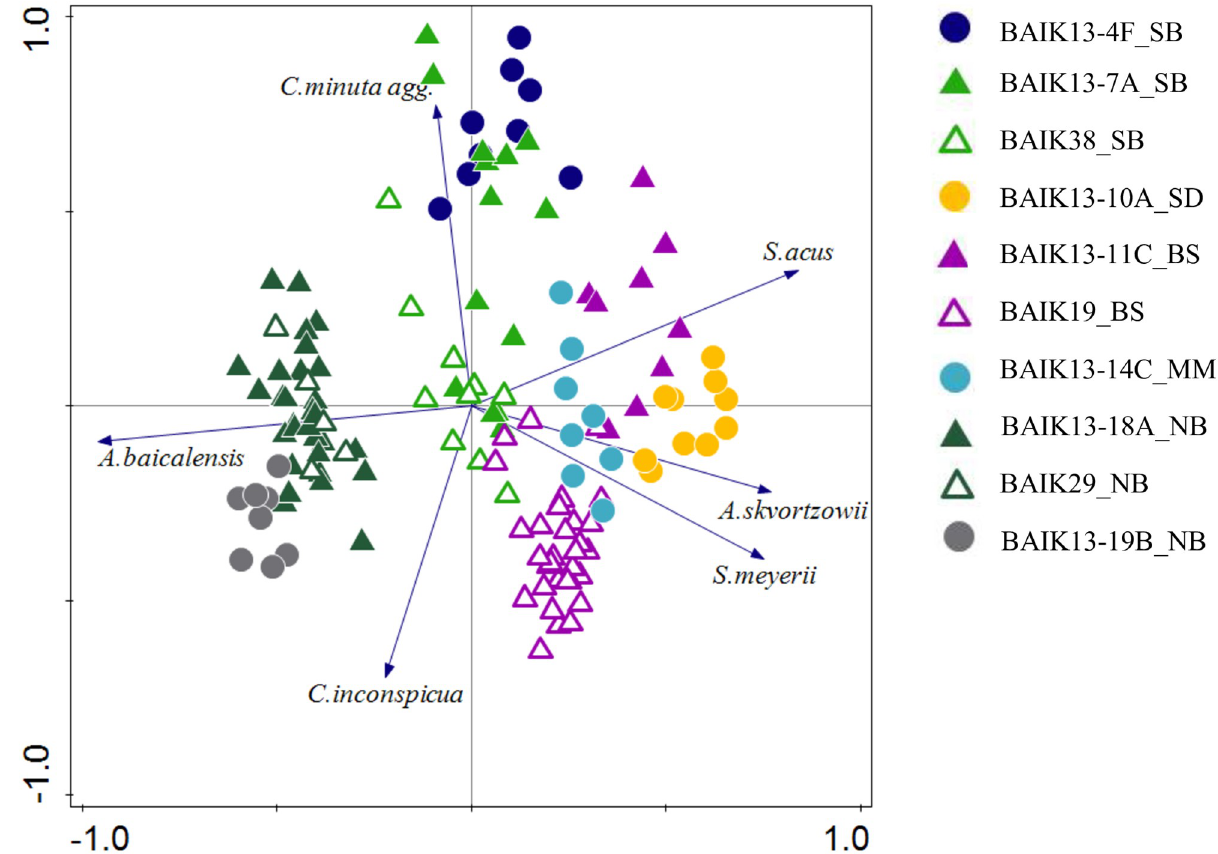
Fig 6. PCA of diatom species from all core samples. Core top samples (upper 2 cm) are from BAIK13-4F_SB, BAIK13-7A_SB, BAIK13-10A_SD, BAIK13-11C_BS, BAIK13-14C_MM, BAIK13-18A_NB and BAIK13-19B_NB sediment cores collected in 2013. The older sediments (20 th century sediments) are from cores BAIK19_BS, BAIK29_NB and BAIK38_SB [31]. Axis one eigenvalue is 0.47 and axis two eigenvalue is 0.24. [SB: South basin, SD: Selenga Delta, BS: Buguldieka Saddle, MM: Maloe More and NB: North basin].